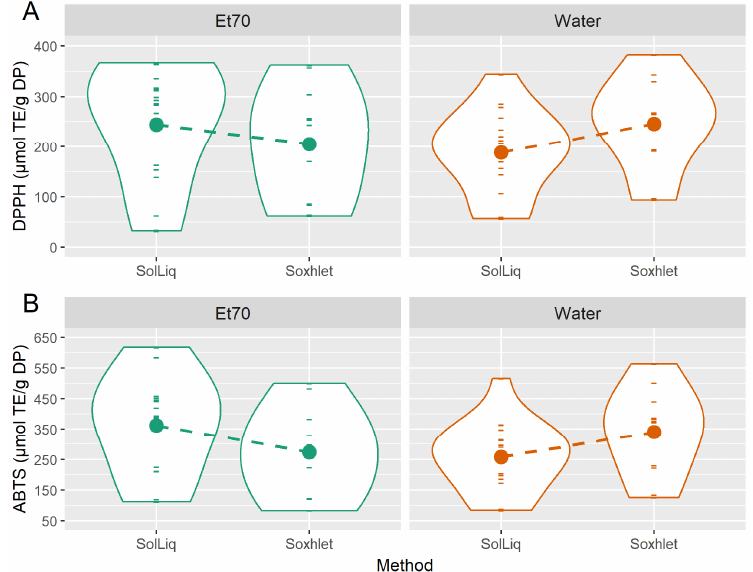
Figure 4. Interaction plots “method × solvent” on the outcomes of the DPPH ( A ) and ABTS ( B ) assays of plant extracts.